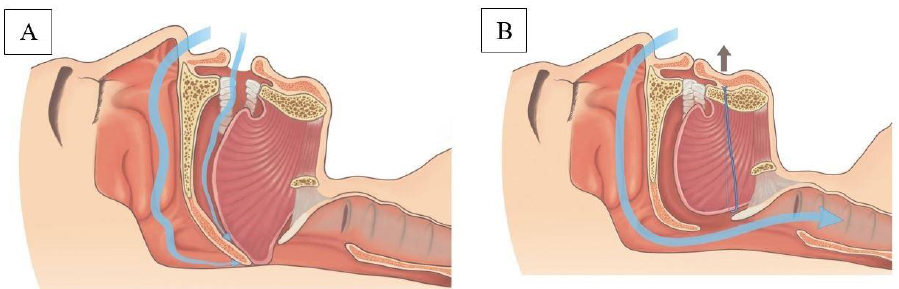
Figure 1. Sketch depicting the proposed change in the hypopharyngeal airflow before ( A ) and after ( B ) transoral tongue suspension.